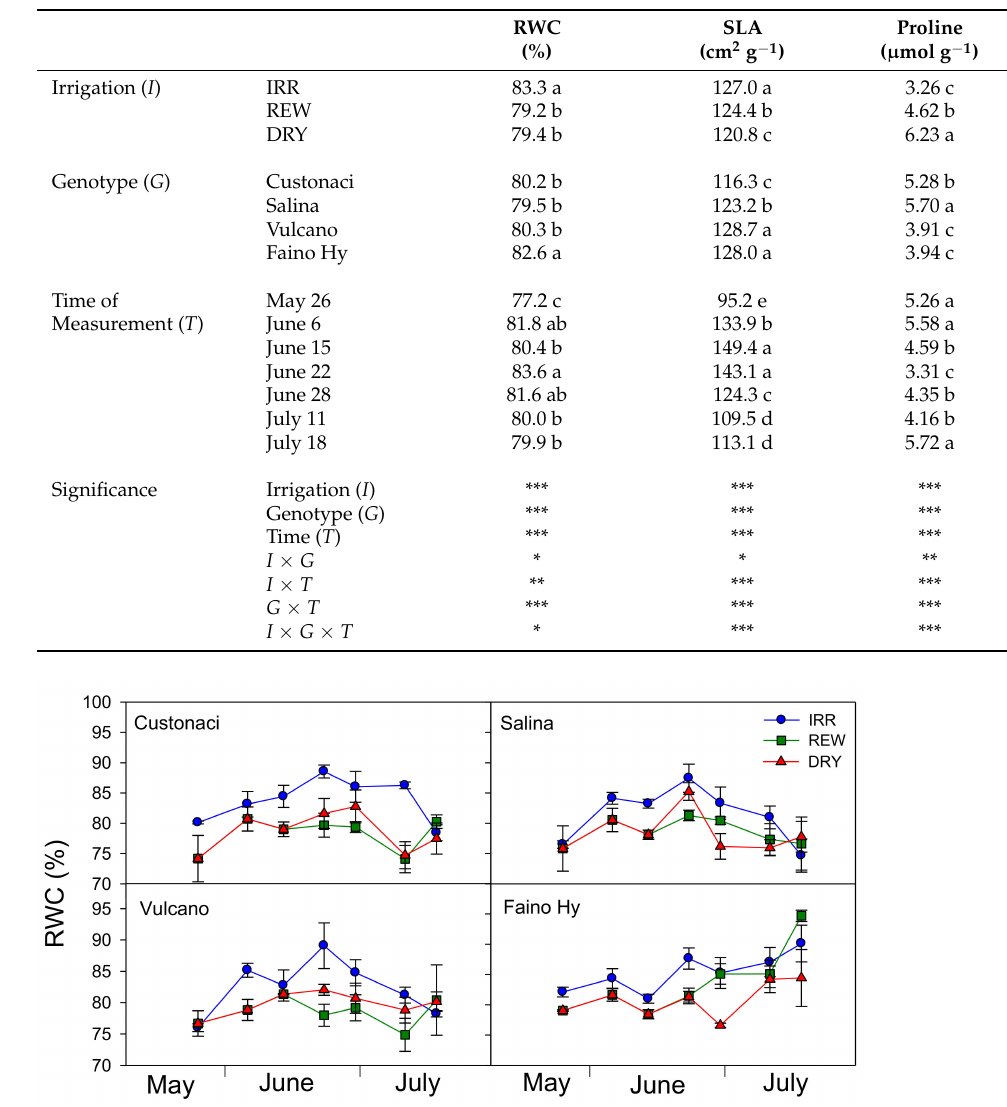
Figure 3. Relative water content of leaves (RWC, %) in four genotypes of tomato in relation to the irrigation treatment (IRR: full irrigation; REW: rewatering; DRY: no irrigation). Vertical bars indicate the standard error ( n =